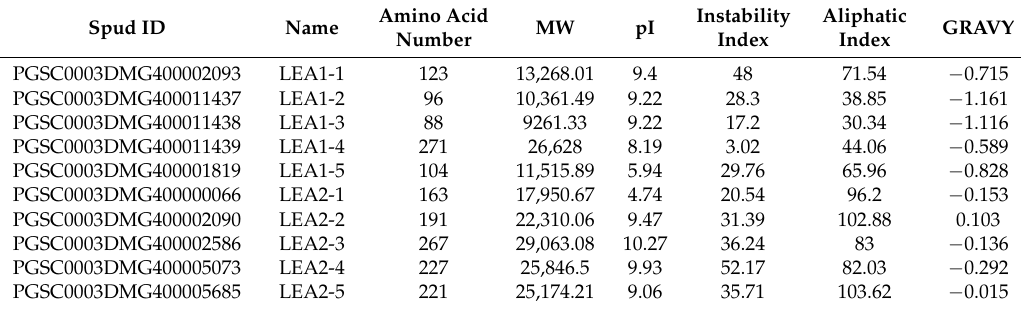
Table 1. Description of late embryogenesis-abundant ( LEA ) genes identified from the potato